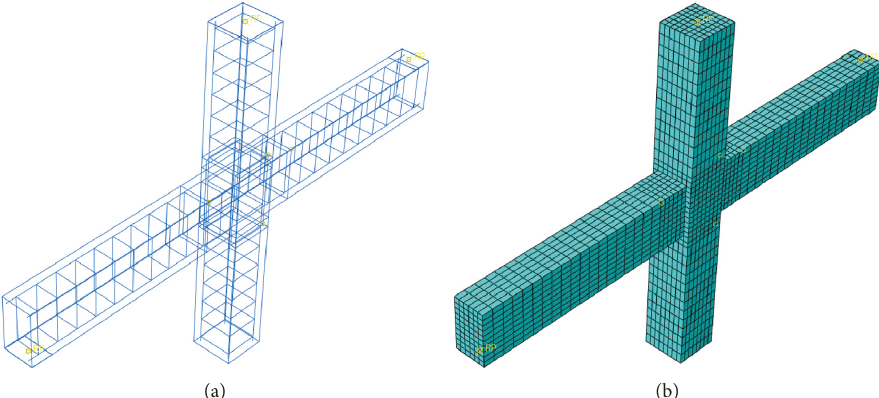
Figure 28: The FE model of the HFRC beam-column joint under pseudostatic. (a) Discrete model. (b) FE